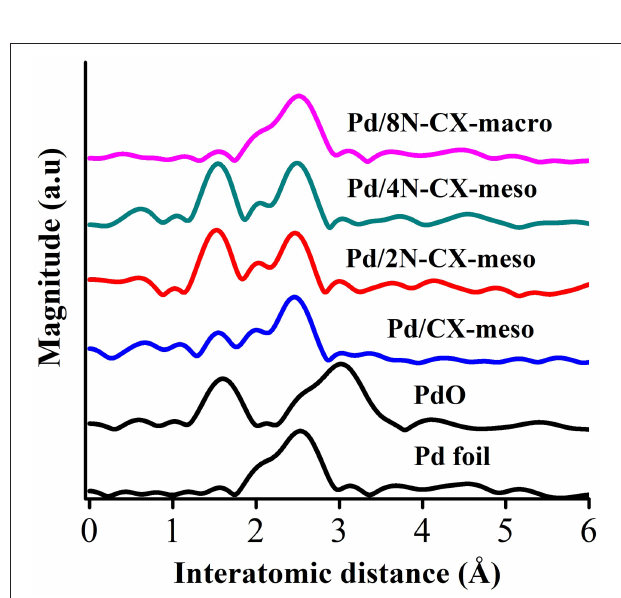
FIGURE 7 | Pd K-edge FT-EXAFS spectra for all catalysts, and Pd foil and PdO as reference samples. Adapted with permission from Navlani-García et al. (2019). Copyright 2019